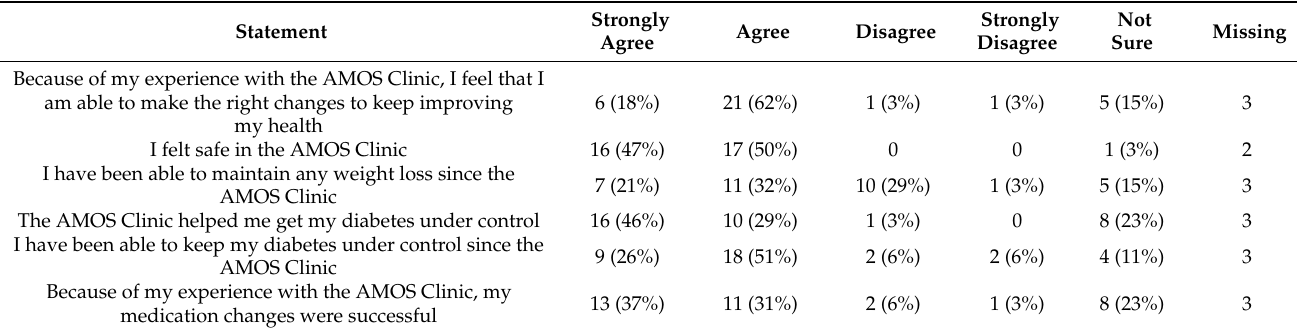
Table 3. Patient survey results—Theme 3: person-centred care.